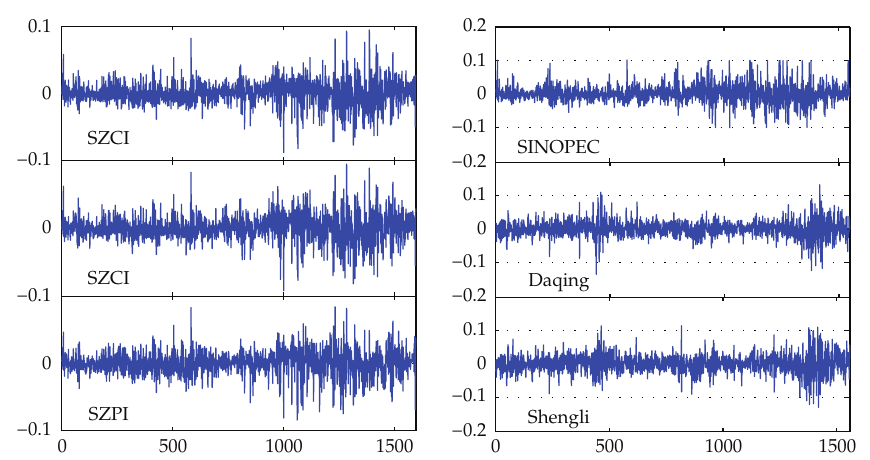
Figure 7: Returns of the indices in the 7-year period from January 2003 to December 2009.